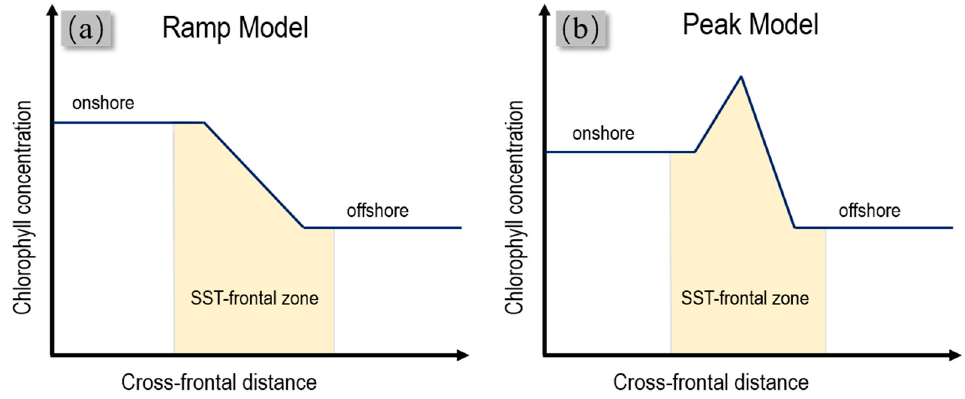
Figure 10. Two kinds of models of chl-a distribution across the SST-frontal zone, redrawn after [2]. ( a ) Ramp Model. ( b ) Peak Model.